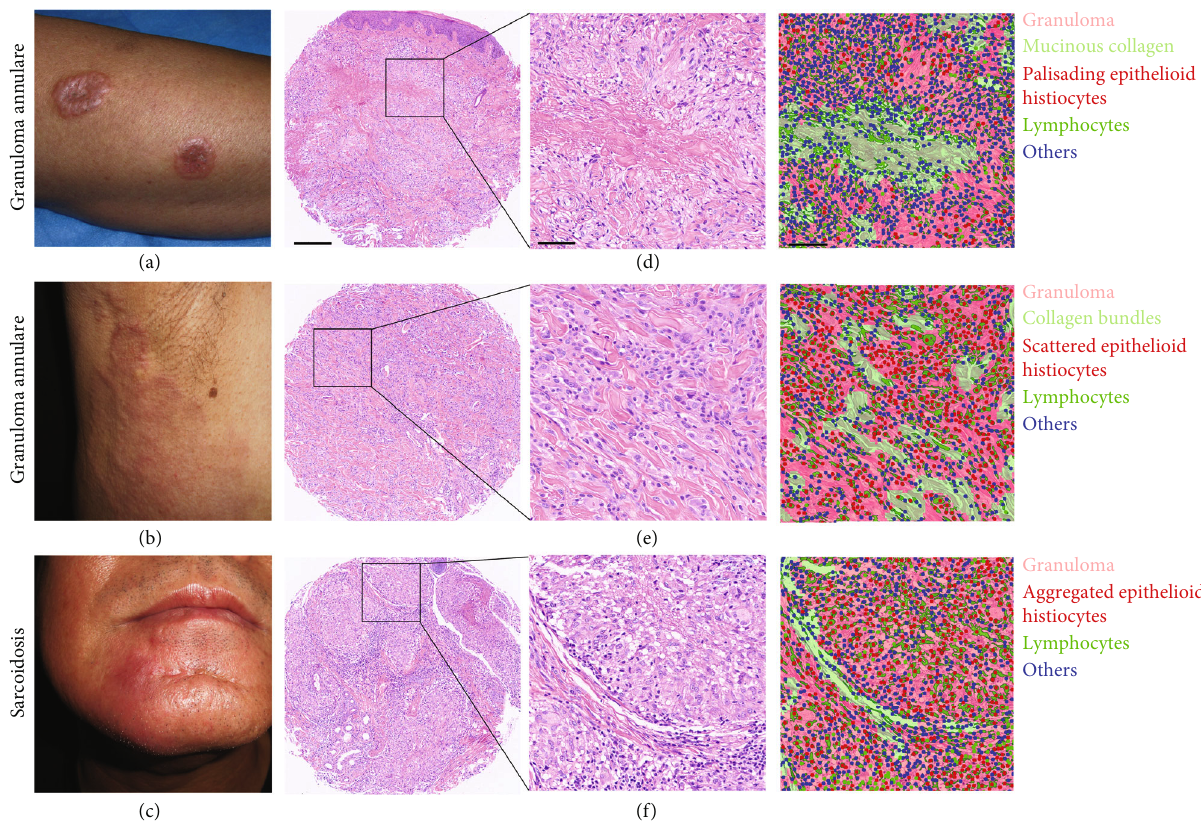
Figure 1: Granuloma annulare and sarcoidosis. (a, b) Clinical photographs for granuloma annulare (GA). (c) Clinical photograph for sarcoidosis. (d) Hematoxylin and eosin (H&E) staining and segmentation of GA biopsy section with palisading pattern of in fi ltrate. (e) H&E staining and segmentation of GA biopsy section with interstitial pattern of in fi ltrate. (f) H&E staining and segmentation of sarcoidosis biopsy section. Lower-power photo, scale bar = 250 μ m ; high-power photo, scalebar = 60 μ m